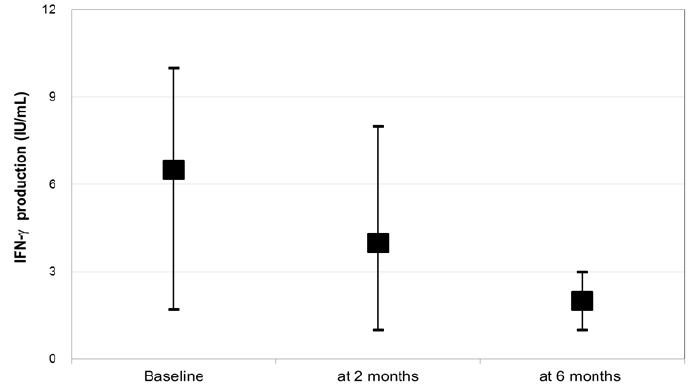
Figure 1. IFN- γ production levels were determined using serial QFT-GIT assays (at baseline, 2 months, and 6 months after treatment initiation) in subjects with active tuberculosis who were on a standard regimen ( N =